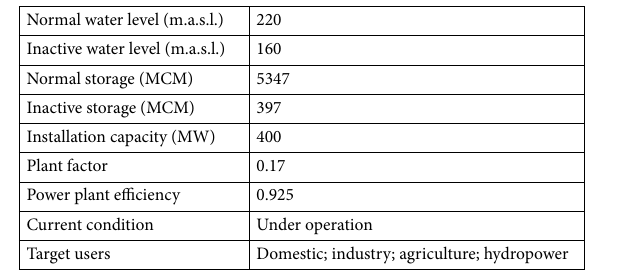
Table 1. Technical characteristics of the Karkheh Dam.